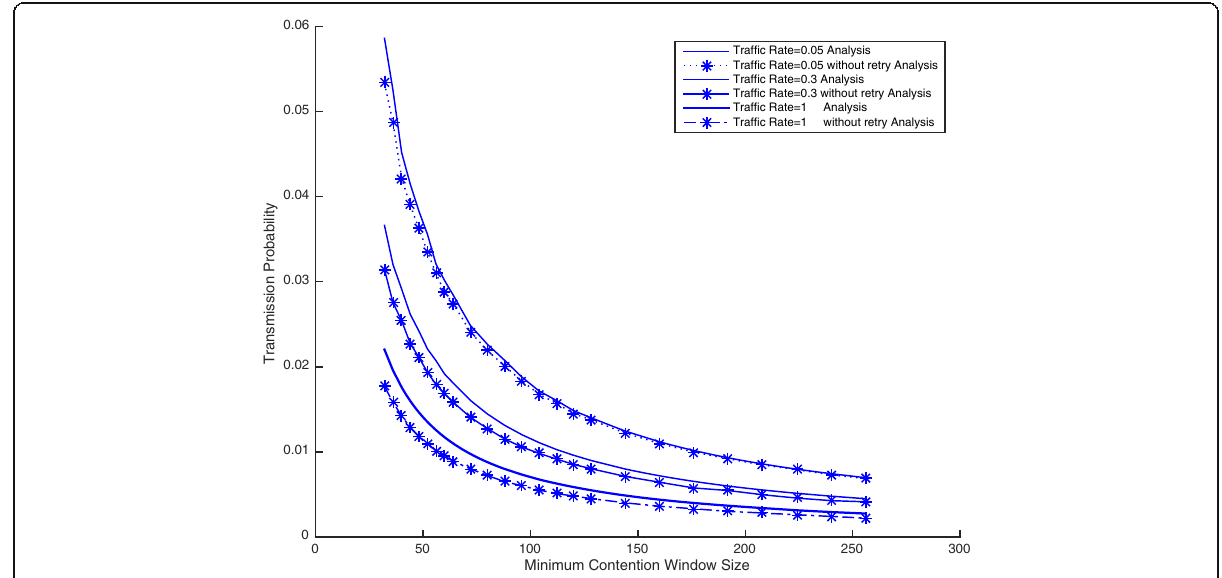
Fig. 4 Transmission probability with a retry limit vs without a retry